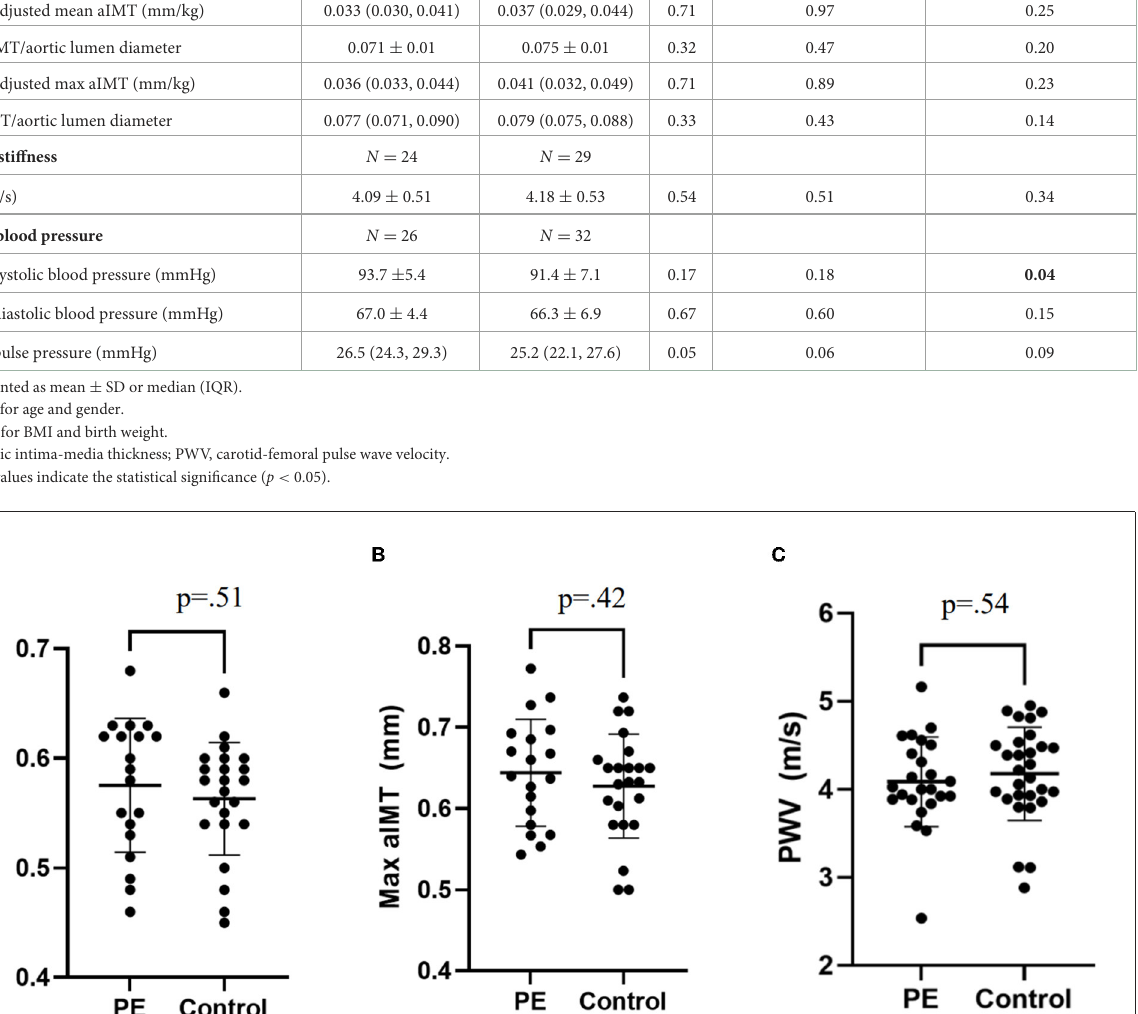
participants in order to sufficiently perform the